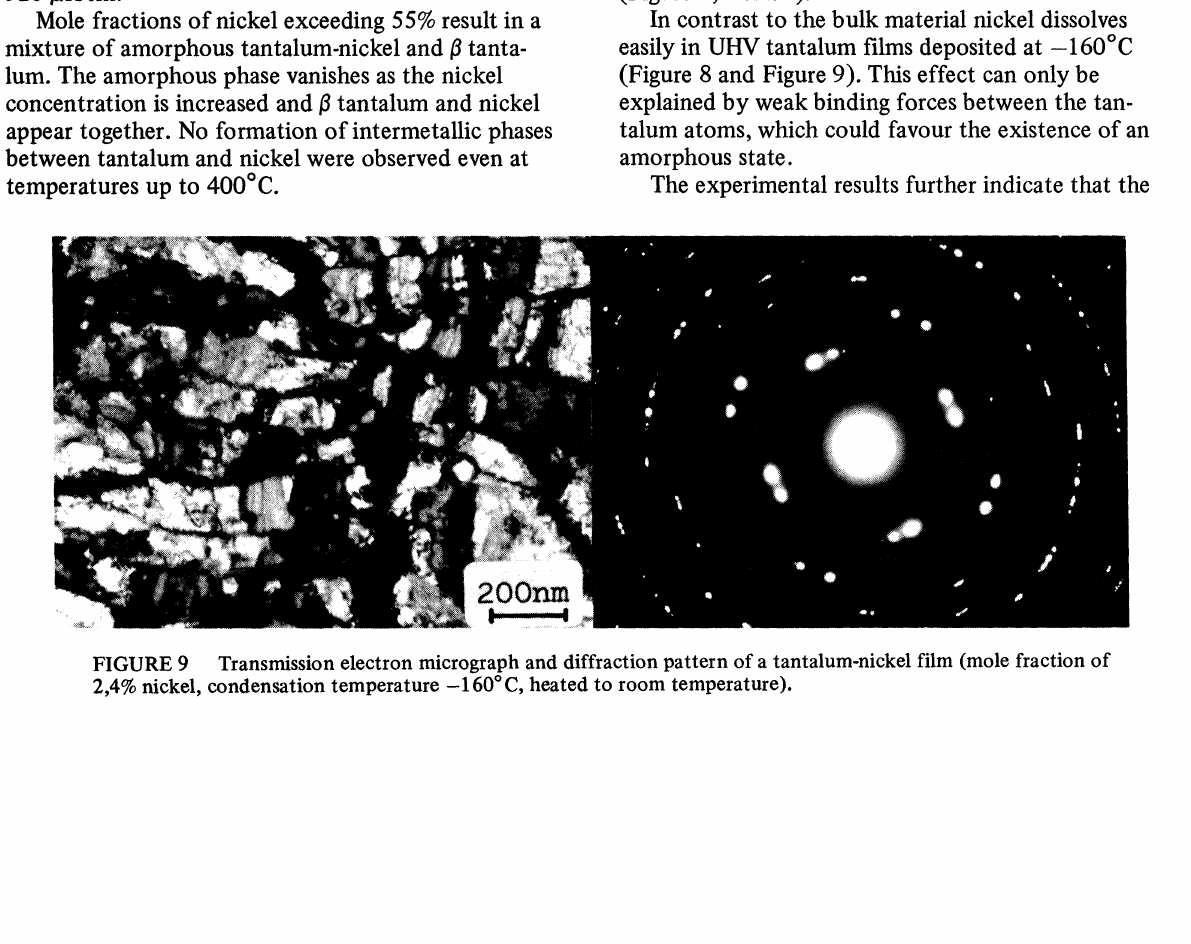
FIGURE 9 Transmission electron micrograph and diffraction pattern of a tantalum-nickel film (mole fraction of 2,4% nickel, condensation temperature -160 C, heated to room